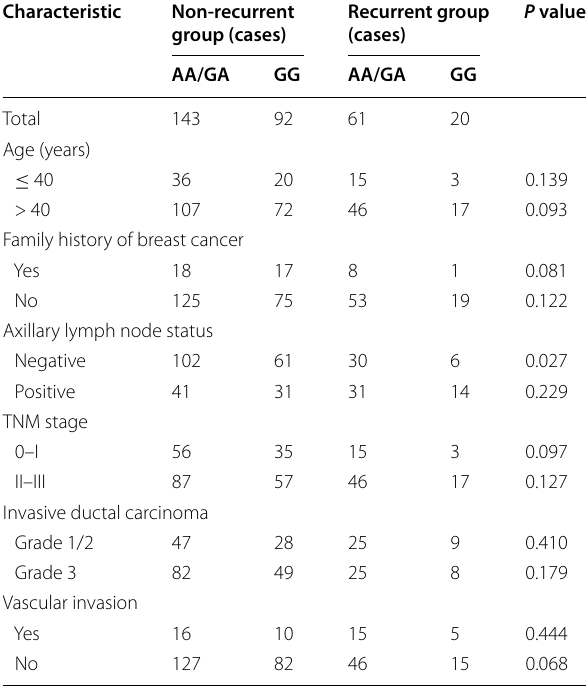
Table 3 The relationship between ATG5 rs473543 geno- types and DFS in the recurrent group and the non-recur-